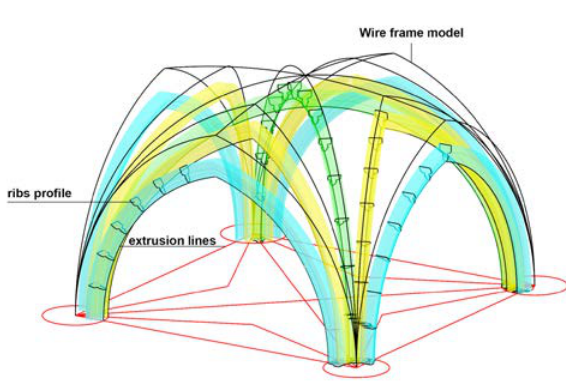
Figure 13 . 3D model generated using parametric tool for tas de charges and using ribs and arches profile based on treatises drawings.